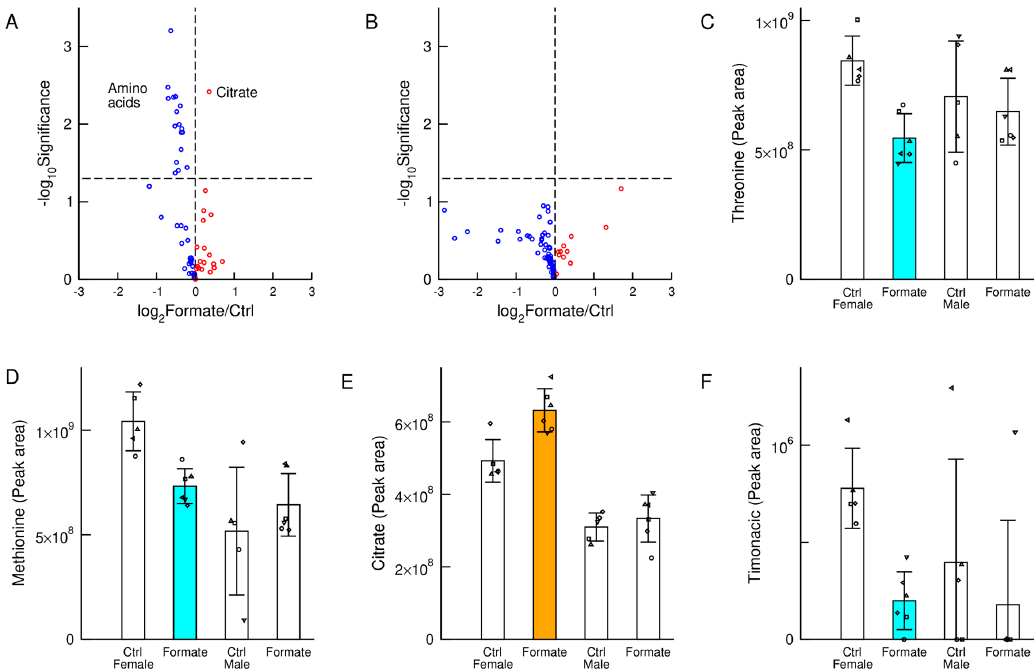
Figure 2. Metabolic changes. ( A , B ) Volcano plots of metabolic differences between plasma samples of mice supplemented with 125 mM of sodium formate and controls, for female ( A ) and male mice ( B ). The horizontal axis reports the log-ratio and the vertical axis the statistical significance (two tails and unequal variance t -test) in a logarithmic scale. ( C – F ) Levels of the indicated metabolites across the different cohorts. Statistics: Each symbol represents an individual mouse, the bar heights represent the mean and the error bars the standard deviation. Coloured bars highlight a significant change ( p < 0.05) in the cohort with sodium formate supplementation relative to control of the same gender. Orange indicates a significant increase and cyan a significant decrease.